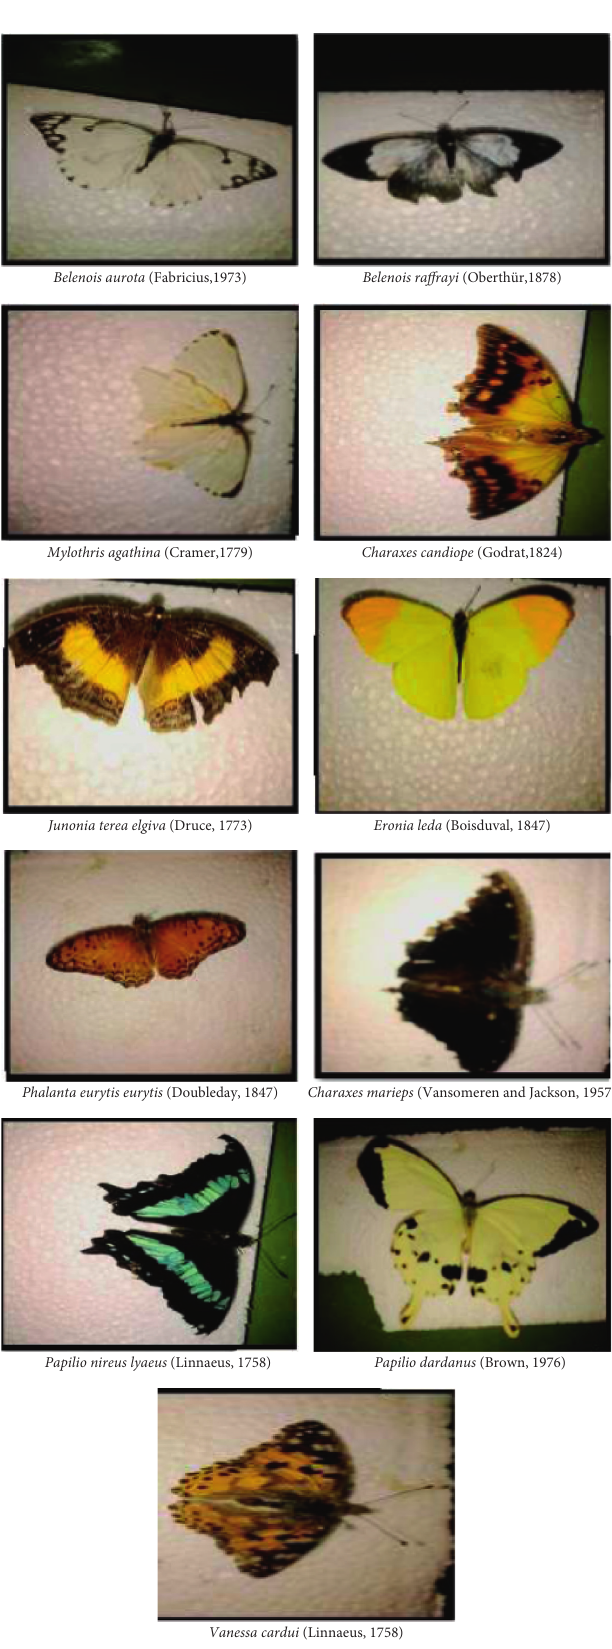
Figure 2: Butterfly species recorded at different locations (photo by the second